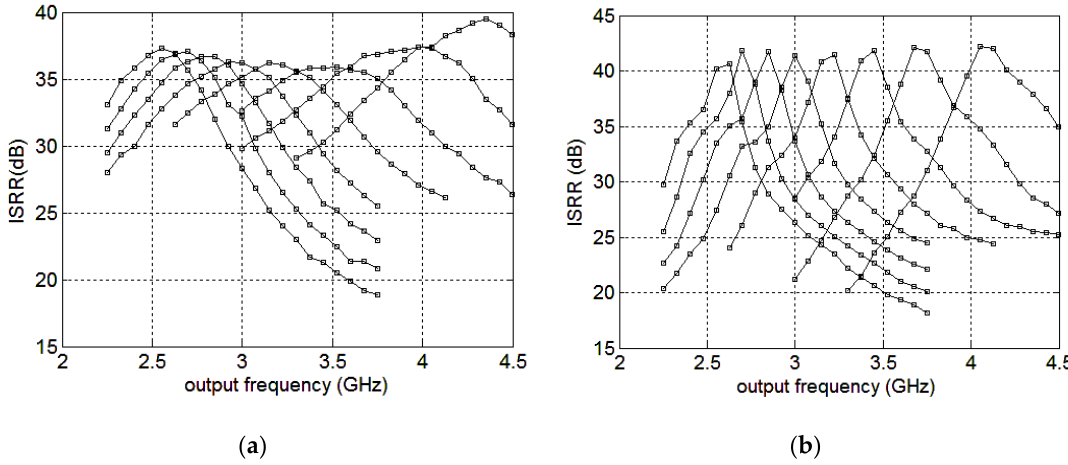
Figure 12. The overall ISRR versus the output frequency at the mixer outputs( a ); and the buffer outputs ( b ).